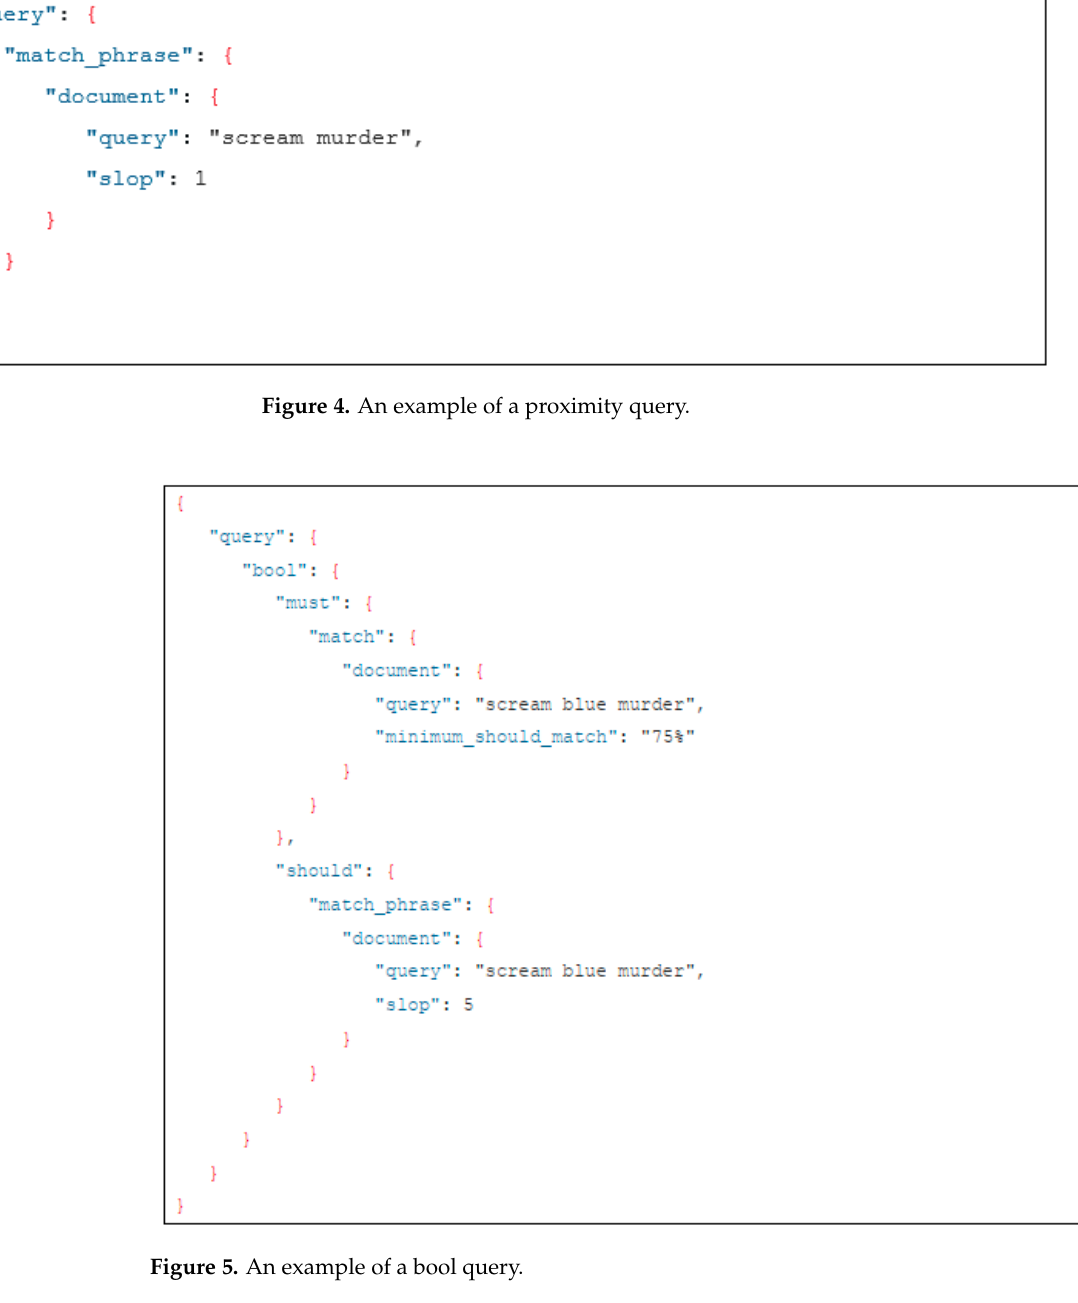
Figure 5. An example of a bool query.